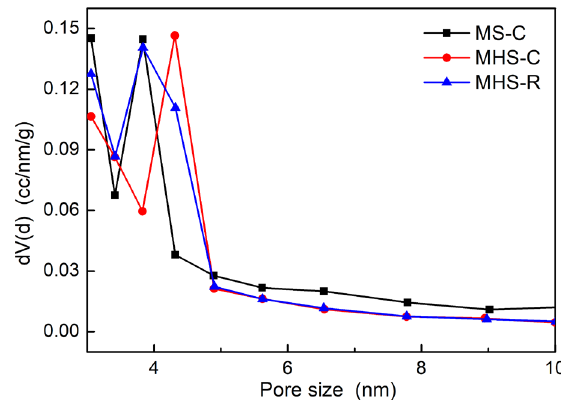
Figure 5. Pore size distributions of mesoporous silica and mesoporous hollow silica. Table 1. Textural properties of mesoporous silica and mesoporous hollow silica.